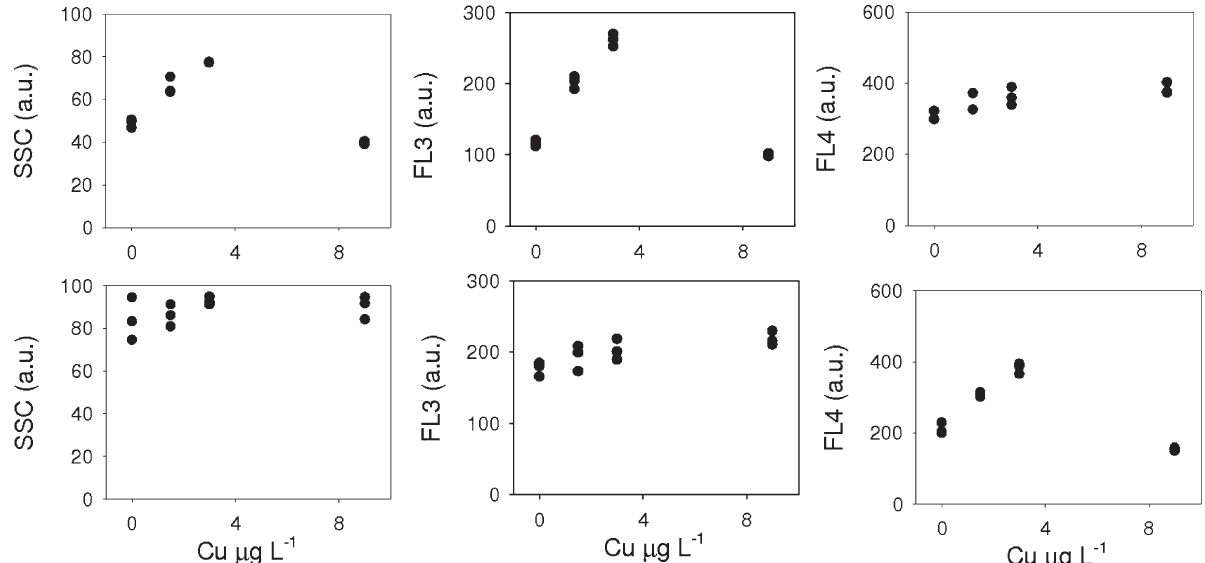
Fig . 6. – Data of size, chlorophyll a , and phycocyanin (in arbitrary units), for the two most sensitive coastal populations studied; top charts correspond to population C3 and bottom charts to population C4.